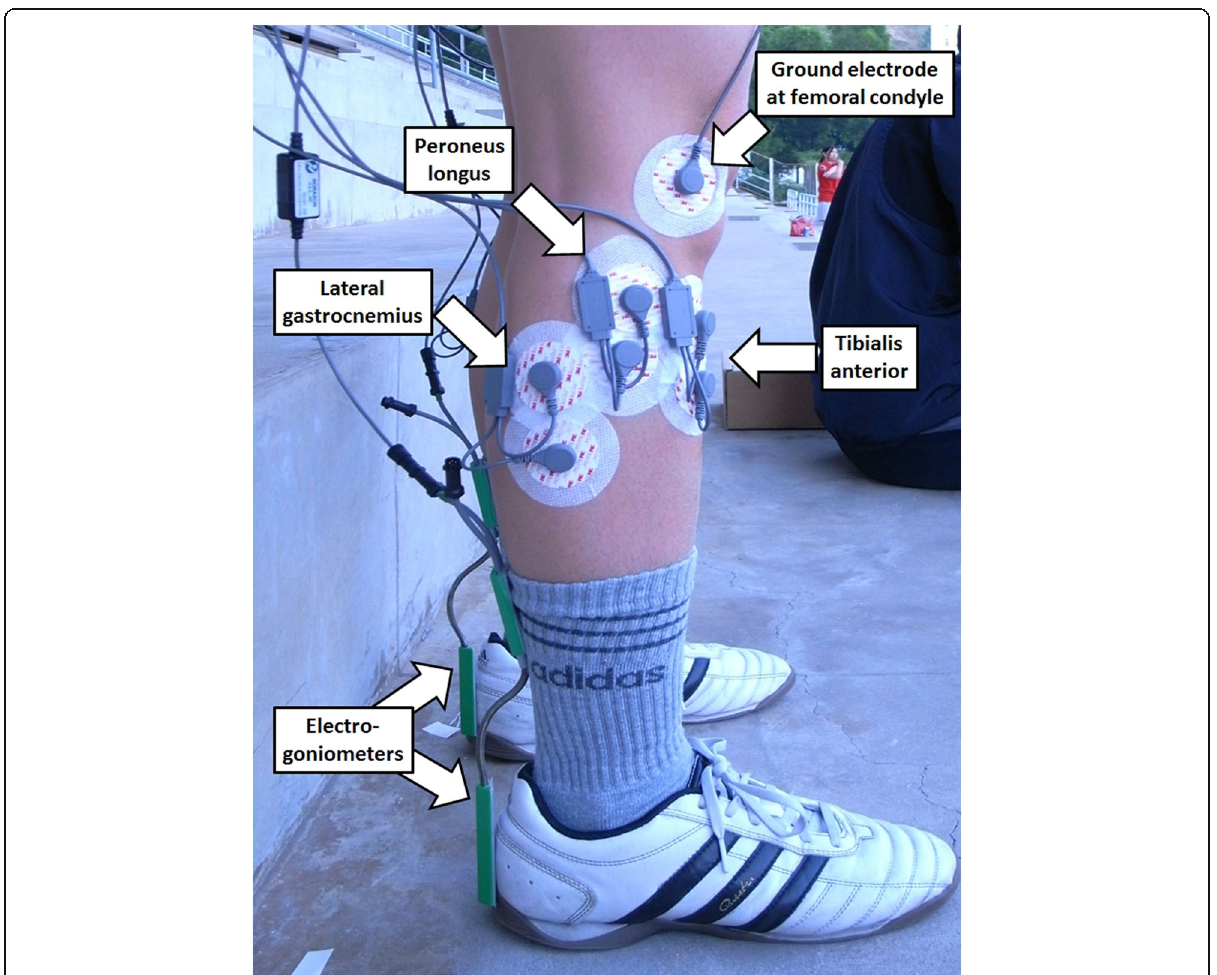
Fig. 2 The locations of electrodes for collecting electromyography signals, and the electrogoniometers for collection ankle inversion data